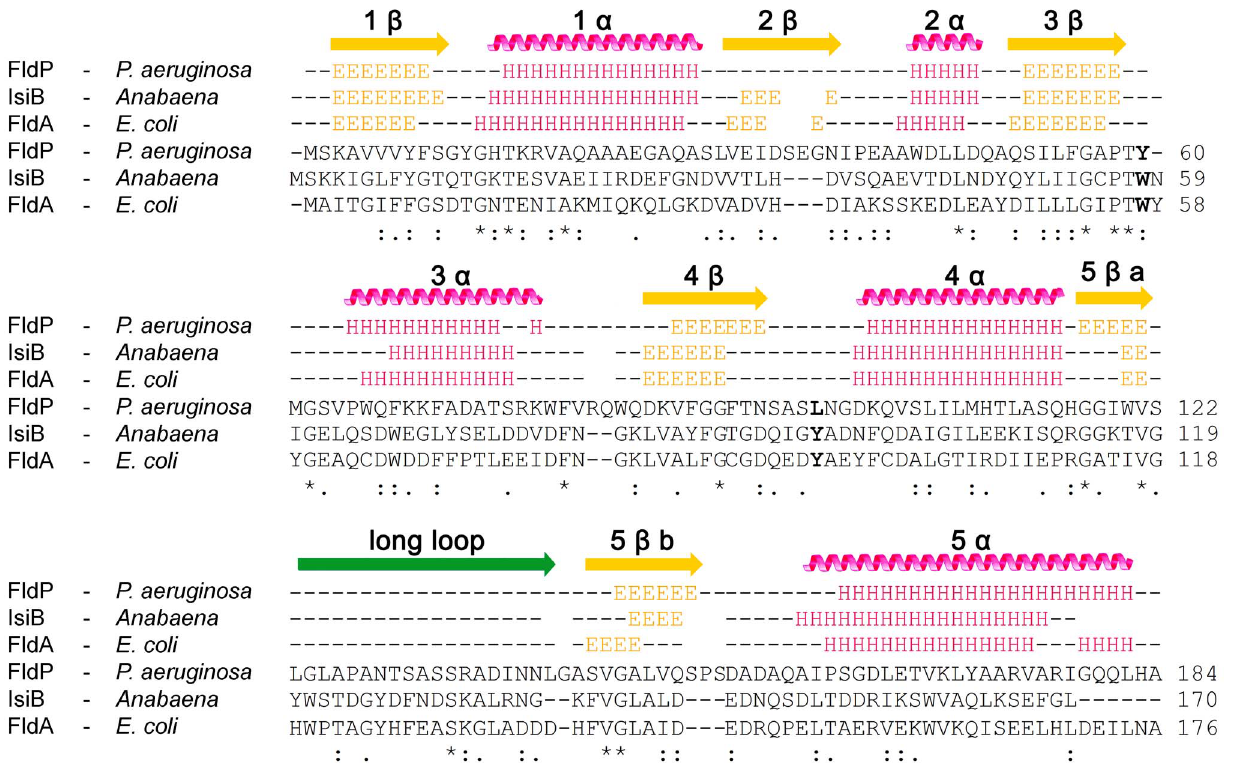
Figure 1. Primary and secondary structures of FldP from P.aeruginosa . FldP sequence was compared with those of well-characterized flavodoxins from Anabaena (IsiB) and E. coli (FldA). Secondary structure predictions are represented above the sequence alignments. ‘‘E’’ identifies amino acids involved in b -sheets (yellow arrows), and ‘‘H’’, those which are part of a -helices (pink helices). The green arrow corresponds to the extra loop that characterizes long-chain Flds. Amino acids in bold (corresponding to W58 and Y95 in Anabaena IsiB) indicate the aromatic residues stacking onto the isoalloxazine ring system in IsiB and FldA, and their equivalents in FldP.